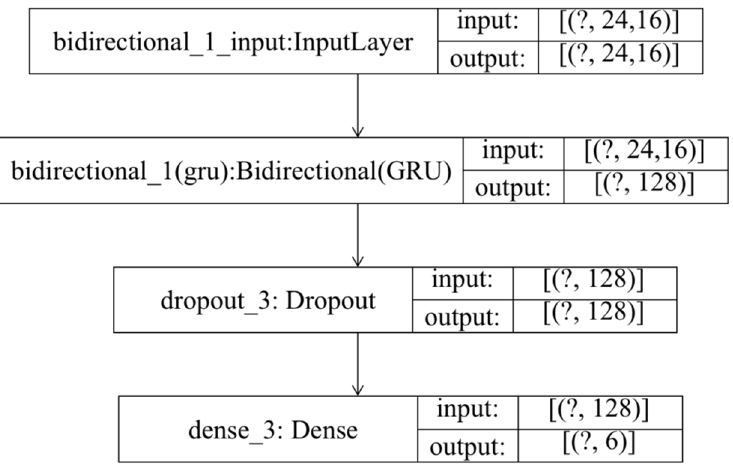
Figure 9. Schematic diagram of PCCs-BiGRU structure model .